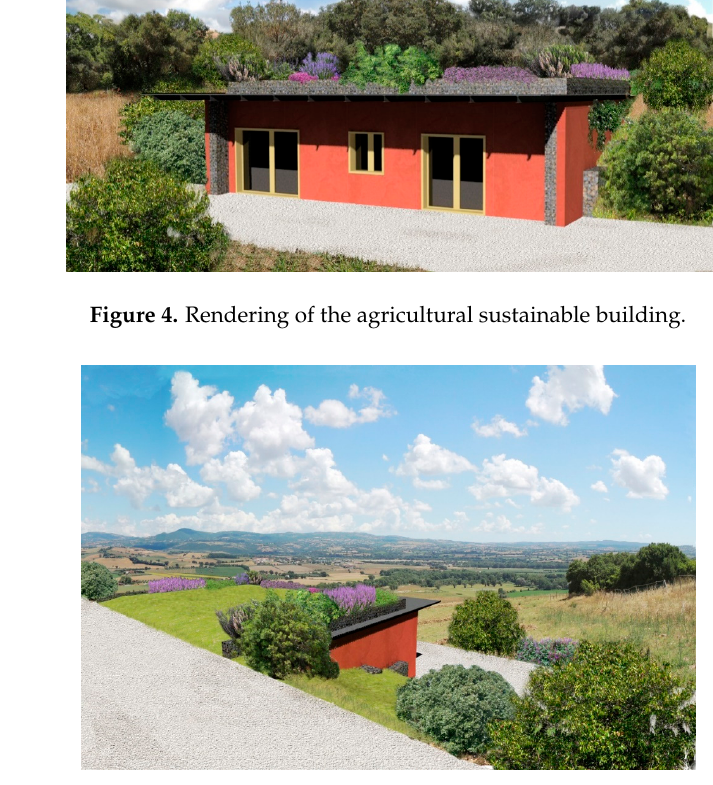
Figure 5. Rendering of the building with particular view of the green roof.